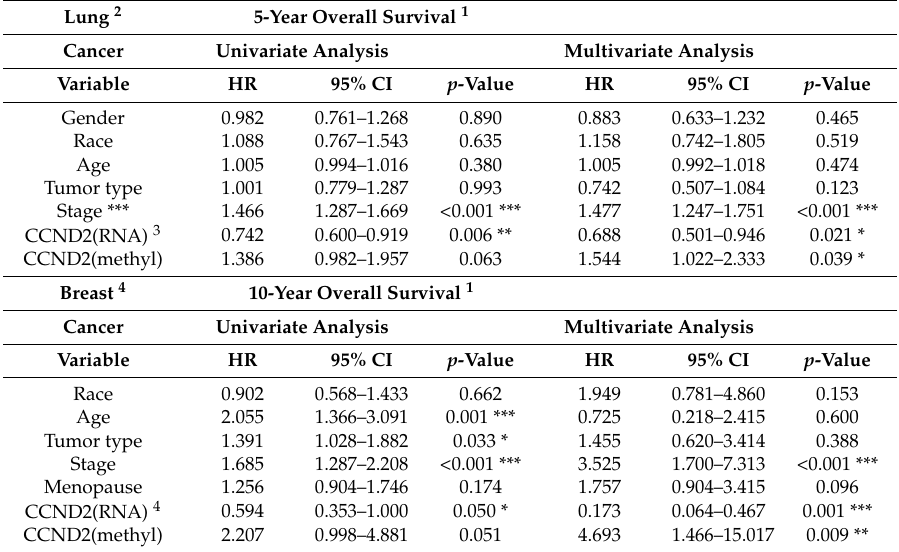
Table 2. Cox proportional hazard model of clinical parameters and CCND2 expression level associated with lung cancer and breast